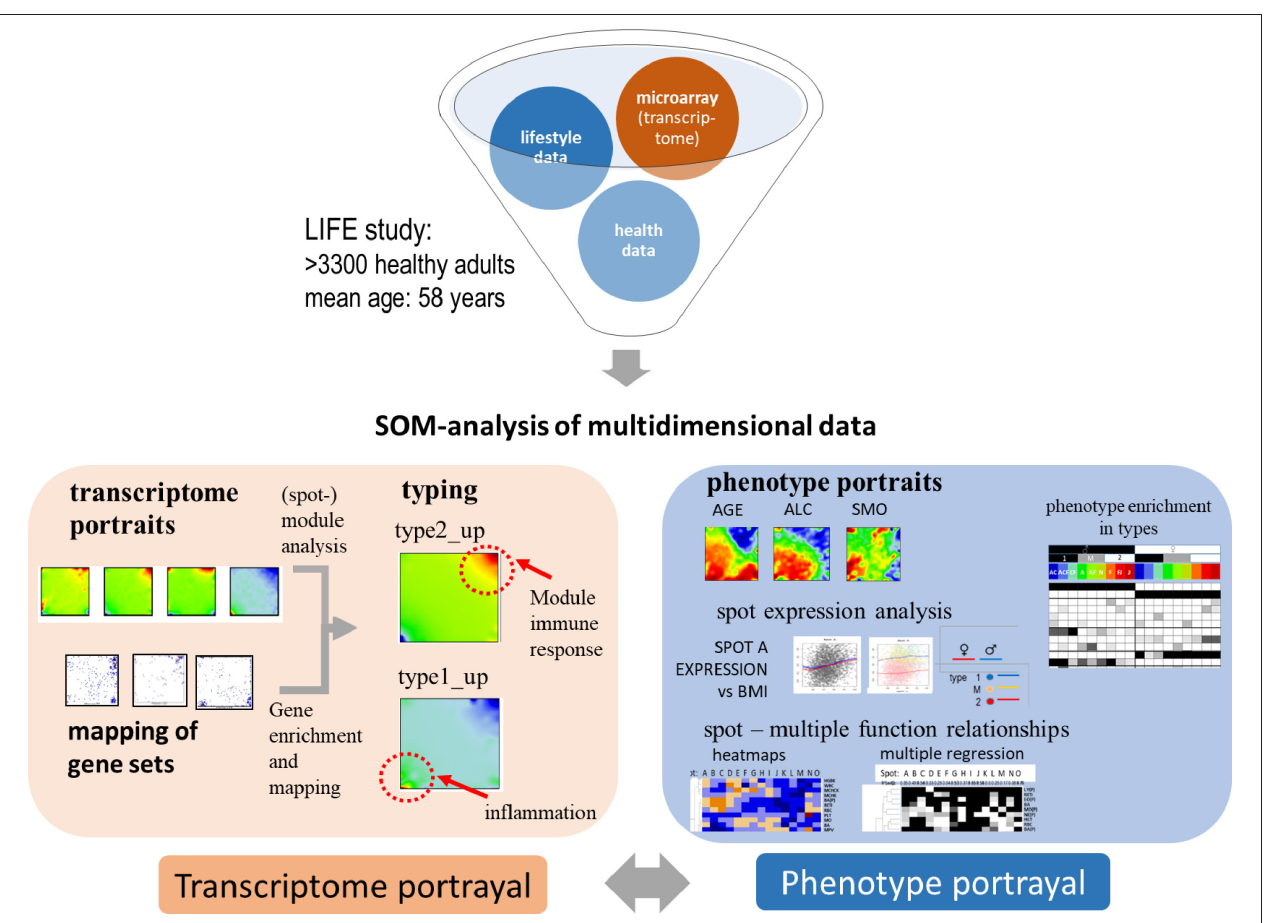
FIGURE 1 | Schematic overview about portrayal approach applied in this study: subject-matched transcriptome and “phenotype” data of the LIFE-adult study were analyzed using SOM machine learning to obtain “personalized” transcriptome portraits. They were used for classification, gene-module extraction, and functional interpretation. Phenotype features such as blood cell counts or BMI provided phenotype (vs.-transcriptome correlation) portraits. For phenotypic features analyzed in this study see Table 1